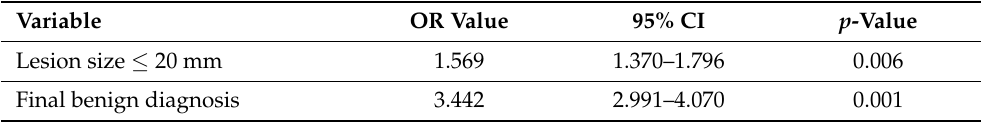
Table 3. Independent risk factors for nondiagnostic biopsy results at multivariate